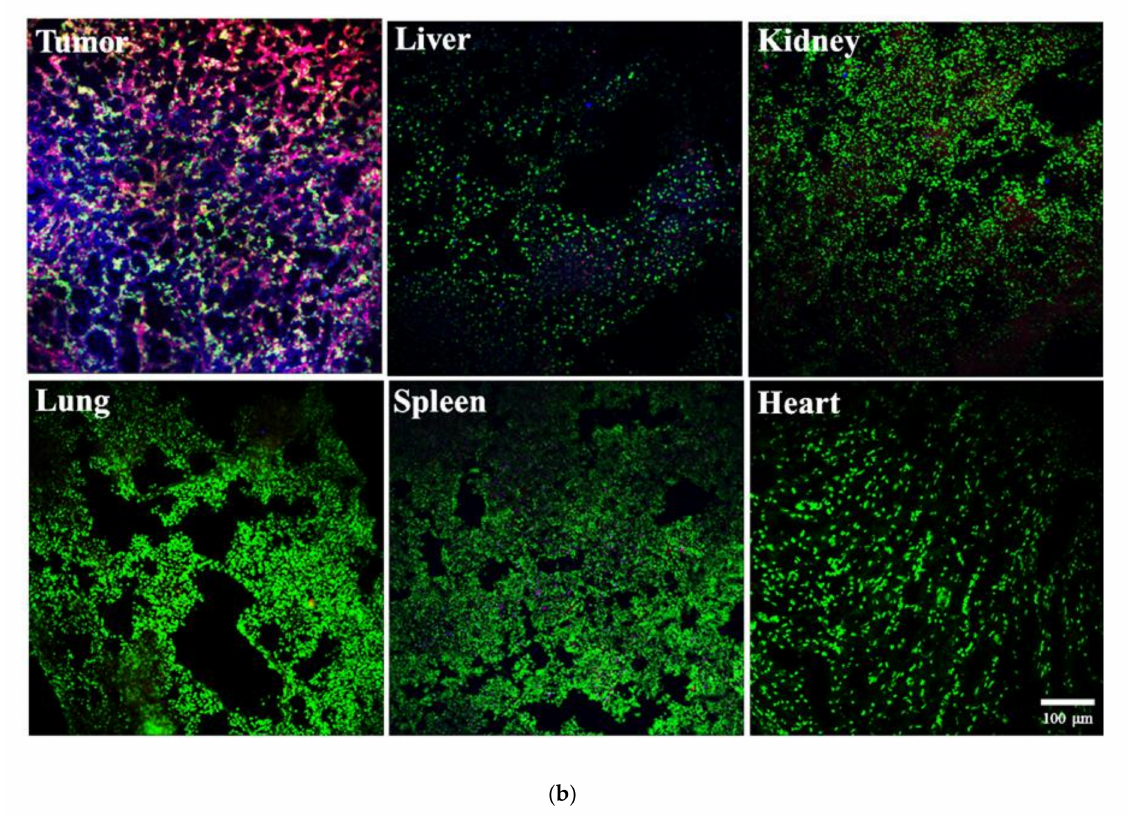
Figure 5. Confocal images of tumors and organs harvested from the mice treated with ( a ) doxorubicin and ( b ) Cy-5.5-labeled Dox-mixed micelles after 72 h i.v. administration. The fluorescence of the doxorubicin and Cy 5.5 is denoted using red and blue, respectively. The cell nuclei were also stained with DAPI and are presented in